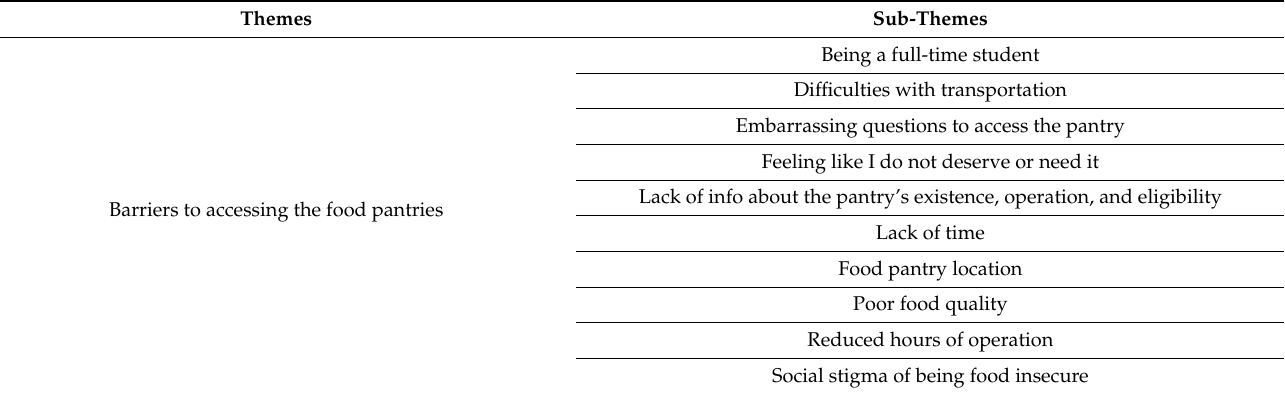
Table 7. Thematic Analysis of Barriers to Accessing the Food Pantries Extracted from Open-Ended Question